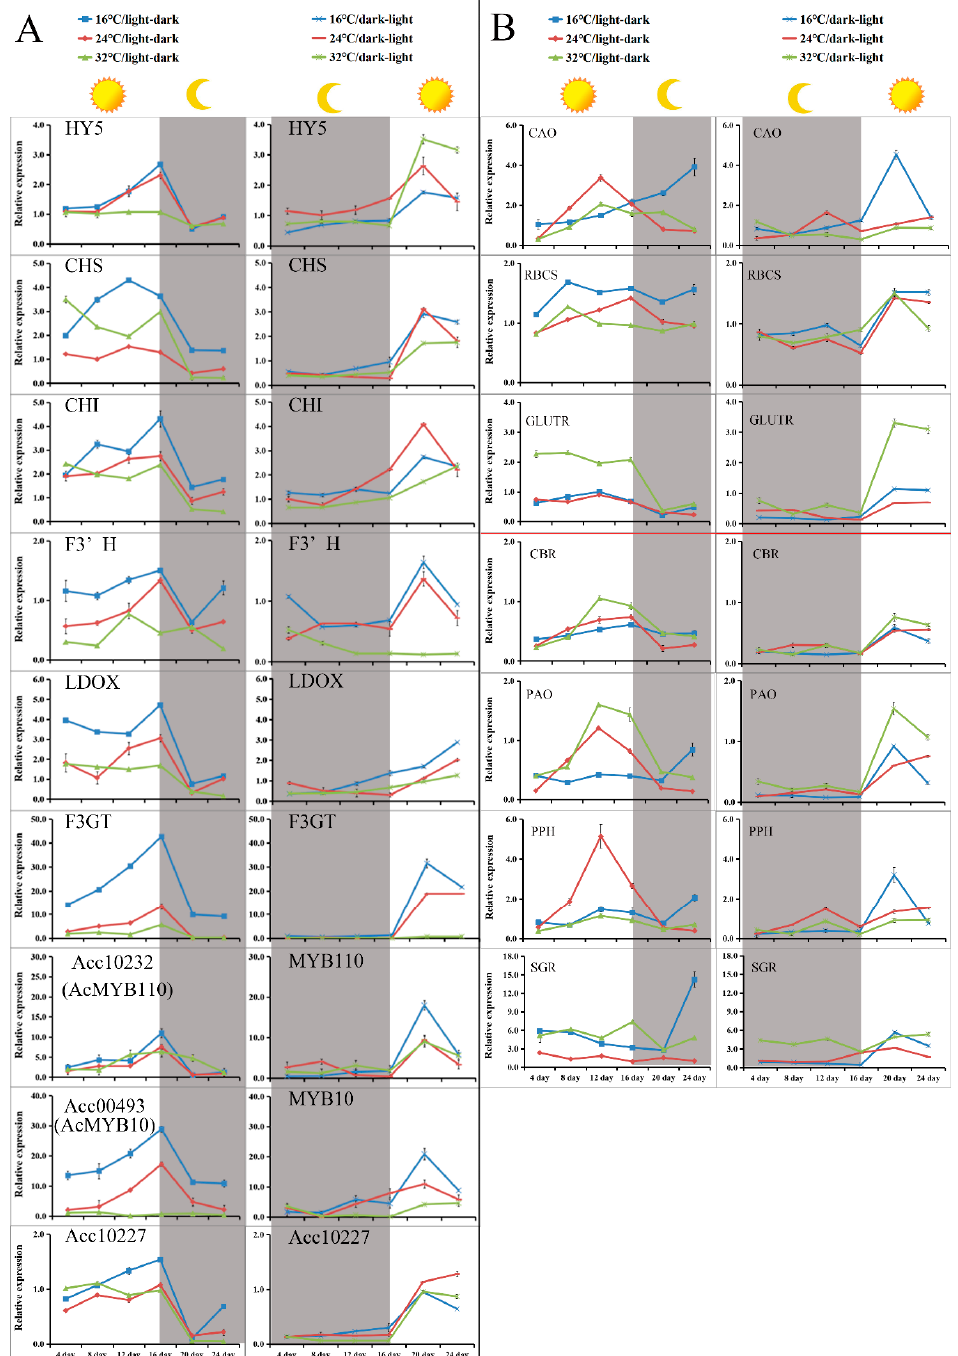
Figure 4. Relative expression levels of anthocyanin- and chlorophyll-related genes in the callus over 24 days under different culture conditions. ( A ) Relative expression levels of the structural genes and AccR2R3-MYBs in the anthocyanin biosynthesis pathway. HY5 , LONG HYPOCOTYL5; CHS , Chalcone synthase; CHI , chalcone isomerase, F3 ′ H , flavanone 3 ′ -hydroxylase; LDOX , leucoanthocyanidin dioxygenase; F3GT , UDP flavanone- 3-Oglucosyltransferase. ( B ) Expression levels of genes related to chlorophyll metabolism. CAO , Chlorophyll a oxygenase; RBCS , Small subunit of ribulose-1,5-bisphosphate Carboxylase; GLUTR , Glutamyl tRNA reductase; CBR , Chlorophyll b reductase; PAO , Pheophorbide a oxygenase; PPH , Pheophytin pheophorbide hydrolase; SGR , Stay-green. Results represent the mean ± SD of three